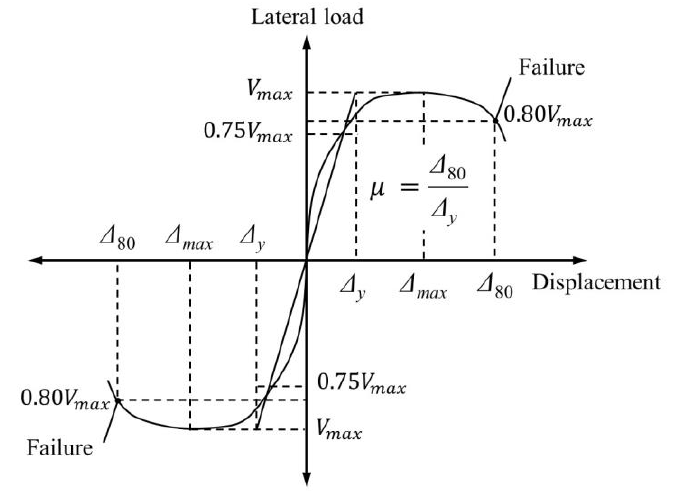
Figure 9. Definition of structural characteristics (structural yielding, failure, and ductility).